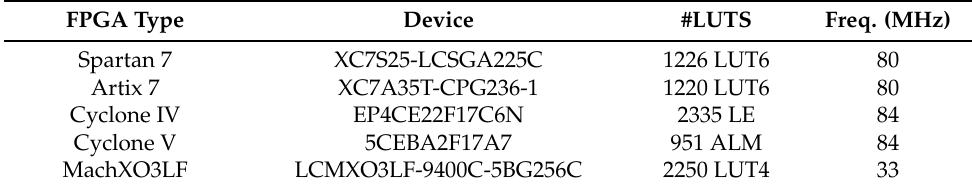
Table 1. T80a implementation